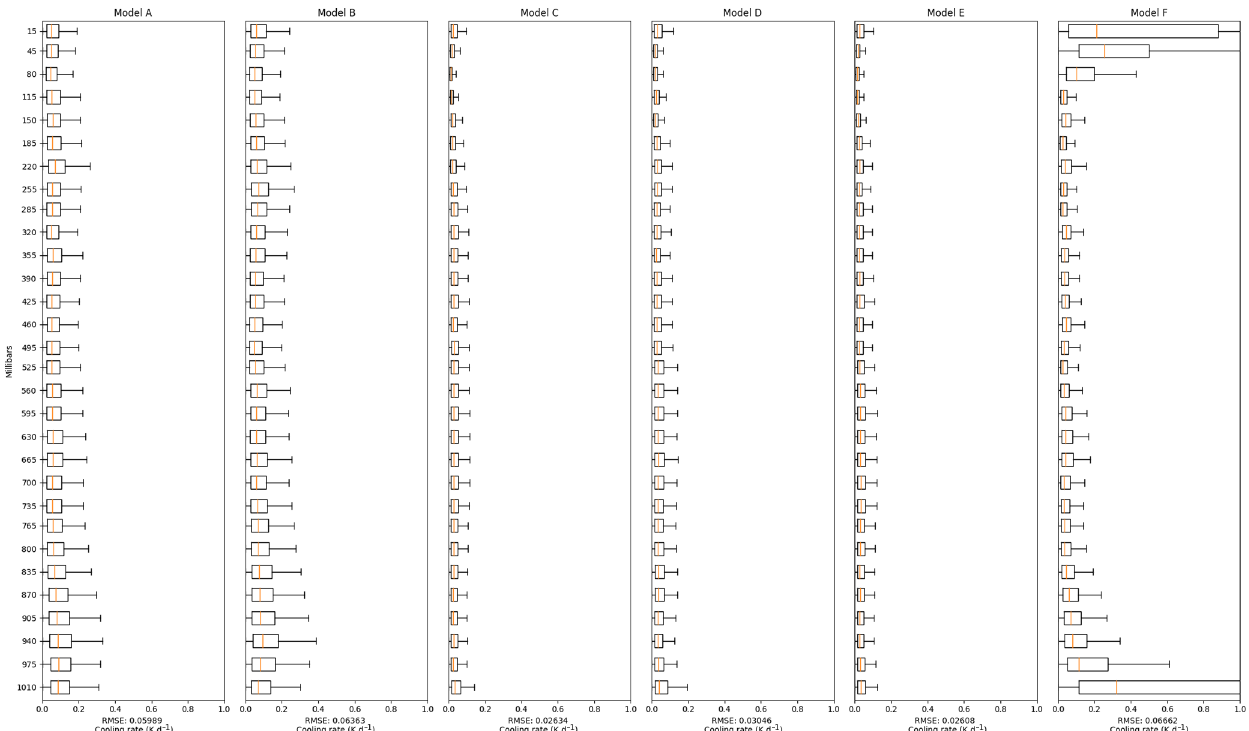
Figure 2. Models are trained with Dataset 1 and evaluated against Dataset 1 . val . The plots have 30 linearly spaced levels between 0 and 101300Pa. The errors from each model are binned to these equally spaced intervals for easier reading. The boxes in the plots present the boxplot of the RT RMSE at every level. Specifically, the boxes describe the 25th (Q1), 50th (Q2), and 75th (Q3) percentile of the RMSEs, while the two whiskers extend from the edges of box to 1.5 times the interquartile range (Q3 −